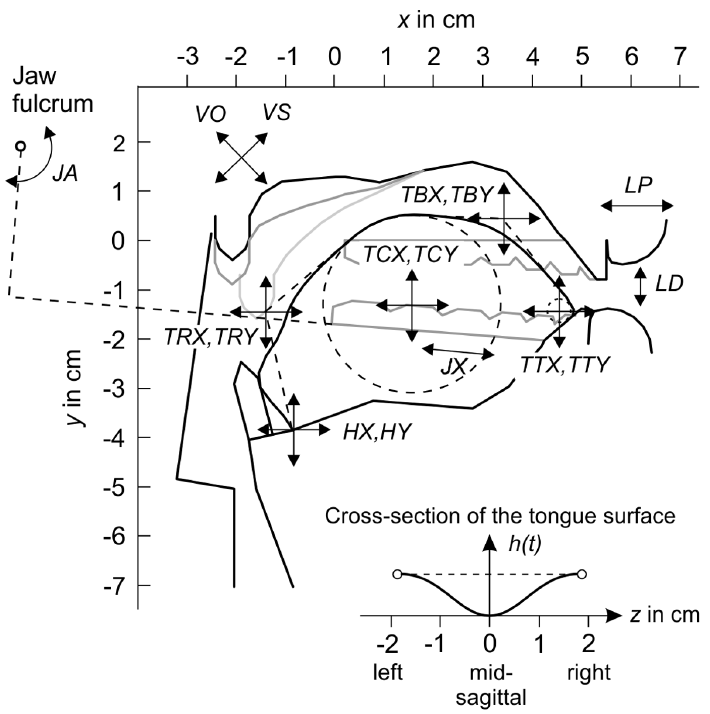
Figure 1. Areas of influence of the vocal tract parameters (adapted from